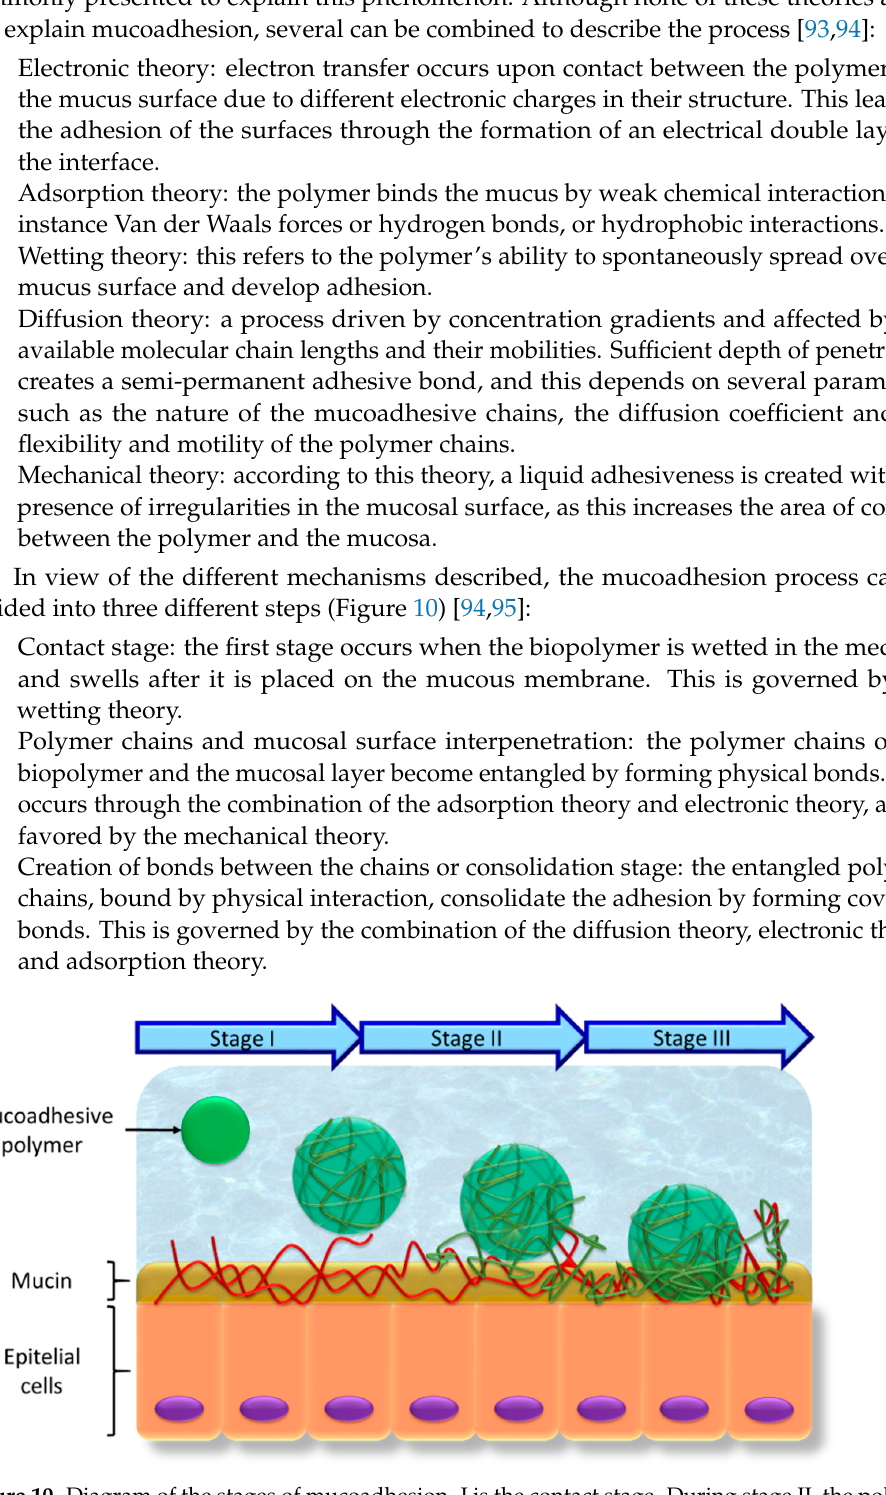
Figure 10. Diagram of the stages of mucoadhesion. I is the contact stage. During stage II, the polymer chains and the mucosal surface interpenetrate. In stage III, covalent bonds are formed between the entangled polymer chains and the mucosal surface. The mucoadhesiveness of the biomacromolecules can be improved through the for- mation of PEC, as the high entanglement between both PEs hinders the penetration of water. This can be attributed to three features: first, the mucoadhesive groups of both bi- omacromolecules are combined within the same systems; second, the system maintains its structure so does not spread, but eventually leaks; and third, the mucoadhesive groups have greater density as the polymer chains are less separated [96]. Finally, mucoadhesion should be considered a characteristic of the system as a whole, so the presence of different functional groups can increase the interaction between the system and the mucosa. Since there is an electrostatic interaction between the oppositely charged polymer chains, the spectra obtained by FTIR corroborates the formation of the PECs by the formation or dis- placement of bands. The modifications must be carefully studied depending on the con- stituent PEs, giving special importance to the bands that can be assigned to the ionizable groups. The three-dimensional structures formed after this electrostatic interaction differ from those seen for each of the components separately. SEM is generally used to observe these processes, and multiple references confirm the presence of unique three-dimen- sional structures thanks to the formation of PECs [84]; as a result, their porosities differ from the constituent polymers, which may be relevant to their functionality. This is the case of scaffolds for tissue engineering, since the systems must allow the correct diffusion of gases in order to maintain a moist environment and enhance cell attachment, prolifer- ation and differentiation [97,98]. It is also important in the case of drug delivery systems, since the pore size can condition the drug delivery process [99]. Porosity studies can be performed by the alcohol displacement method [97,98] or through Hg porosimetry [84]. Lastly, some thermodynamic properties such as the enthalpies or temperatures of the phase transition are frequently modified after the electrostatic interaction of PEs for the formation the PECs [100,101]. Thermogravimetry (TGA) and differential scanning calo- rimetry (DSC) have also been applied to the characterization of PECs. For instance, the thermal degradation determined through TGA is usually modified and the DSC data gen- erally show an offset shift in the peaks observed in the PEs separately, or new peaks— both endothermic and exothermic—may even appear [98,102]. Other more specific techniques can be found in the literature, i.e., rheological analysis [103], ζ -potential [104], mucoadhesion studies [84], and X-ray diffractometry [102], among others.